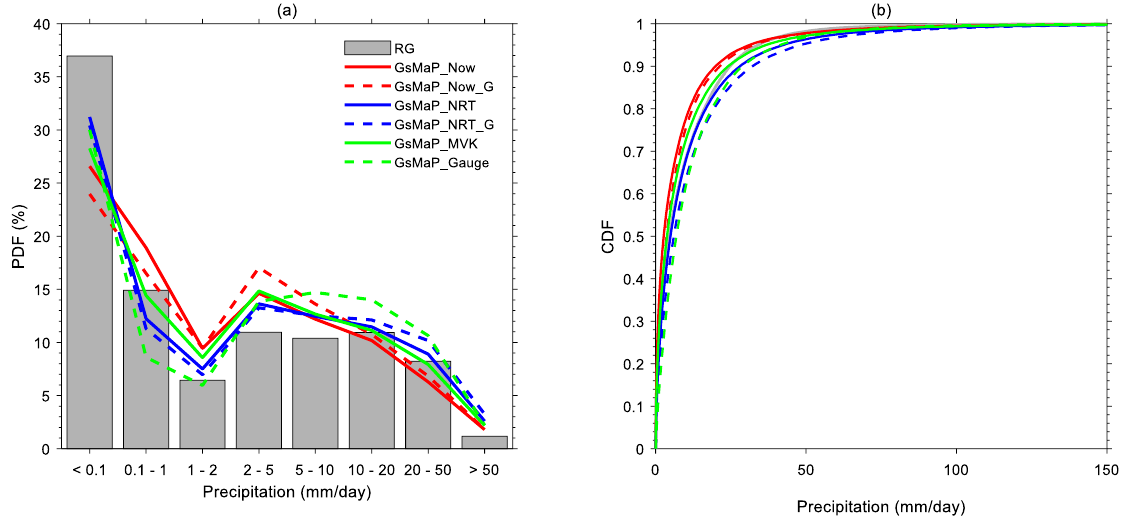
Figure 9. CDF ( a ) and PDF ( b ) for daily data of GSMaP and RG.